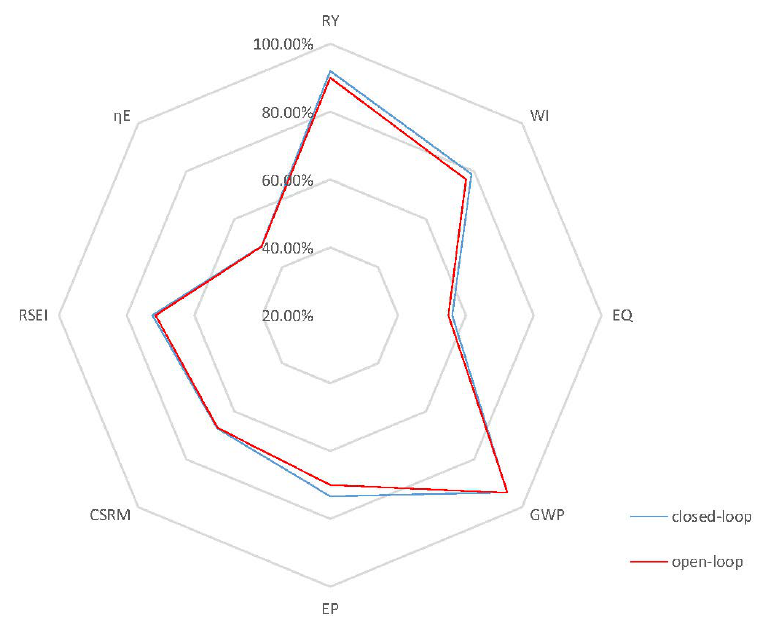
Figure 7. Radar plot with GREENSCOPE (Gauging Reaction Effectiveness for the ENvironmental Sustainability of Chemistries with a multi-Objective Process Evaluator) indicators for the closed-loop and open-loop simulations (Case 1).